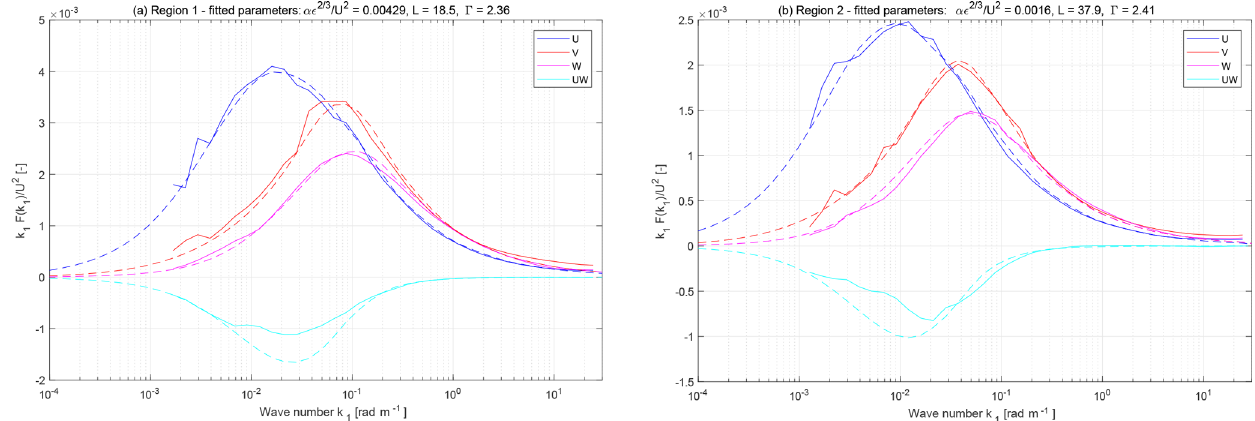
Figure C1. Average spectra and the corresponding Mann model fits from Table 2 for region 1 (a) and region 2 (b) .